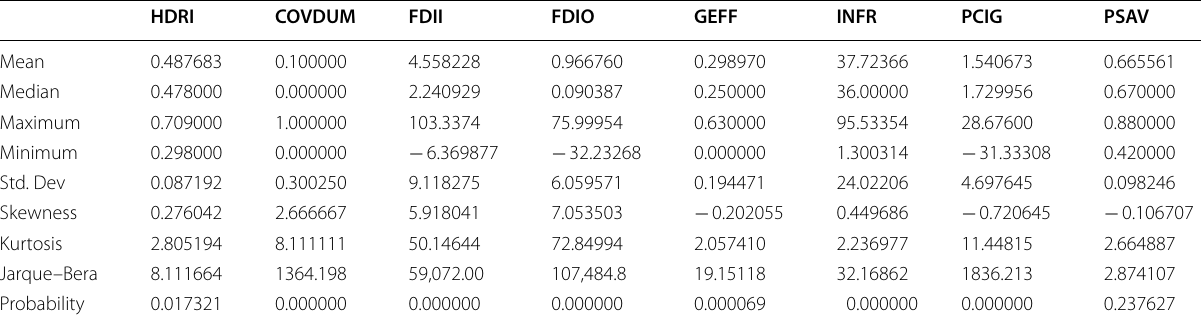
Table 2 Descriptive statistics. Source : Computation from World Development Indicator 2022 using